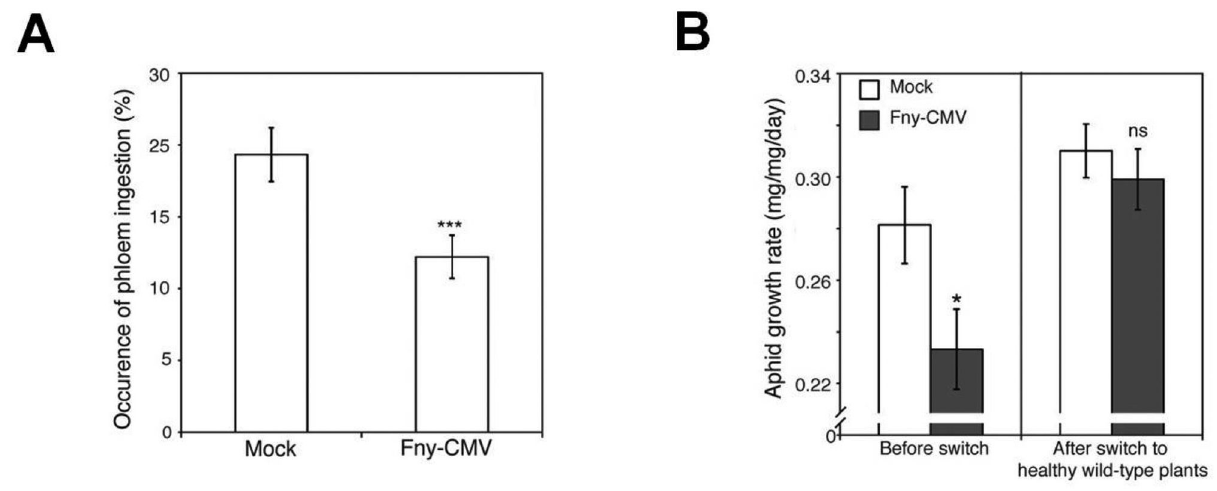
Figure 2. Aphid behavior and performance on virus-infected wild-type Arabidopsis plants. (A) Electrical penetration graph analysis of aphid feeding behavior over 12-hour periods revealed that aphids were less likely to feed from the phloem of Fny-CMV- infected plants, n=15. (B) When aphids previously fed on Fny-CMV-infected plants were moved to uninfected wild-type plants, their growth rate recovered to levels similar to those fed on uninfected plants, n≥24. Error bars represent standard error of the mean. Asterisks indicate significant differences (Student’s t -test): *, P <0.05; **, P <0.01; ***, P <0.001. Non-significant: ns.